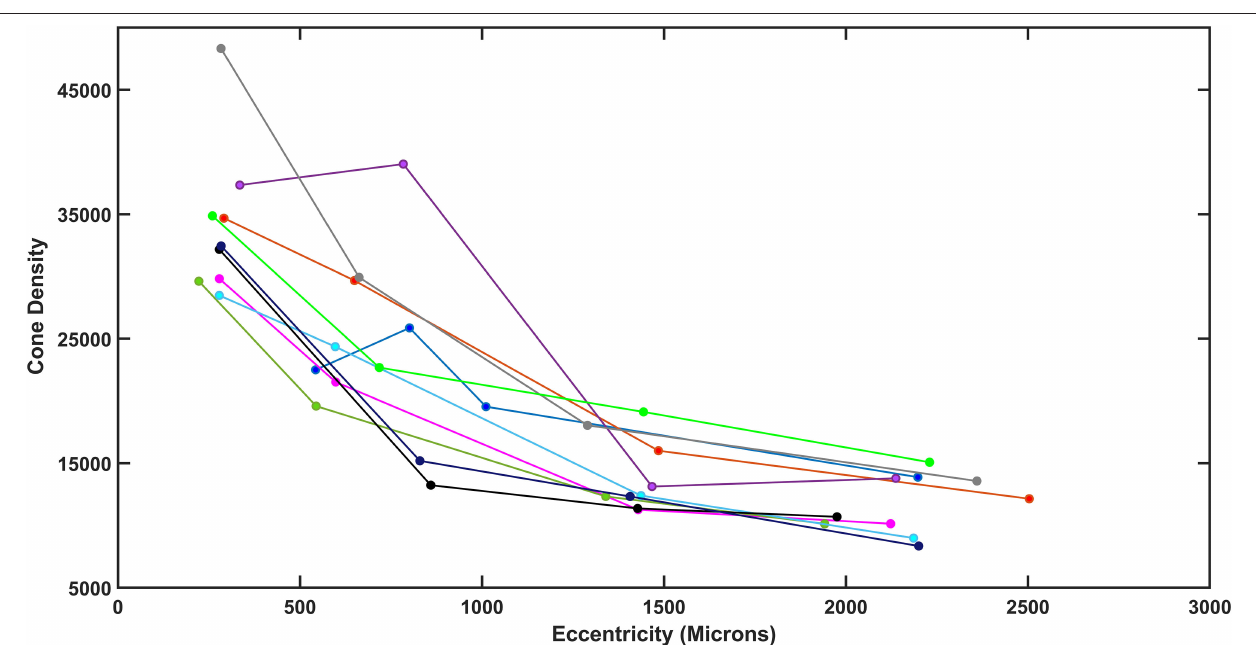
FIGURE 4 | Total density plotted as a function of retinal eccentricity for the diabetic subjects, showing differences among subjects at all eccentricities.